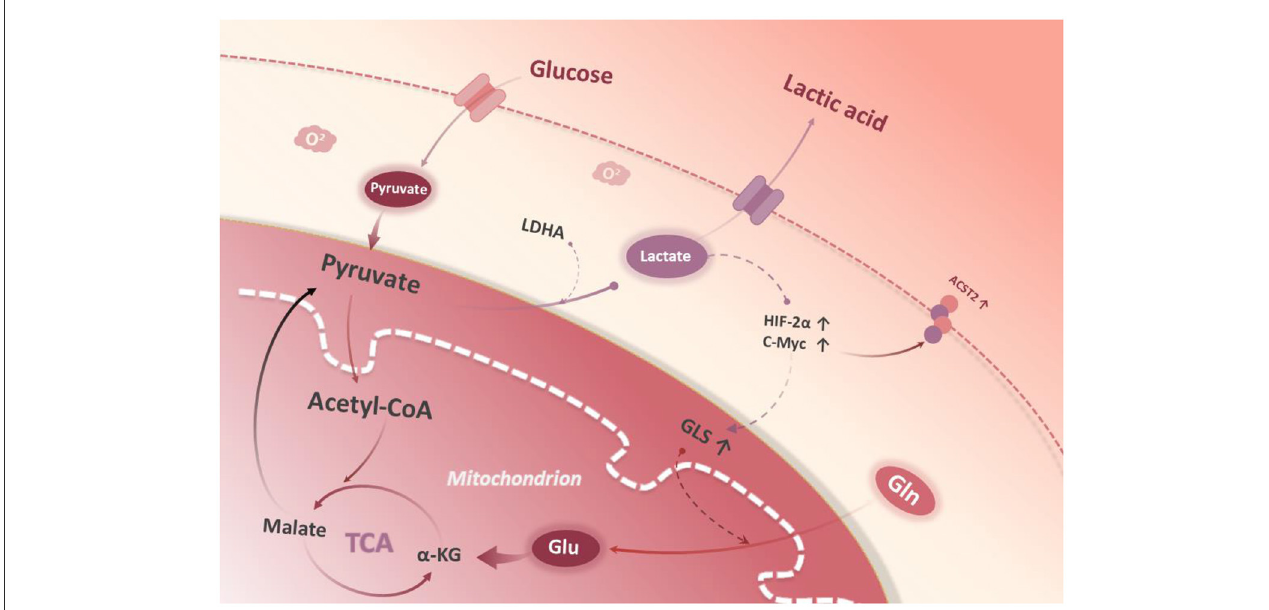
FIGURE1 Glycolysis and glutamine metabolism. Glucose is catabolized to pyruvate in the cytoplasm. Conversion of lactate from pyruvate stabilizes HIF-2a, which then stabilizes c-Myc protein expression in the nucleus. c-Myc promotes glutamine transporter protein 2 (ASCT2) expression. Glutaminase 1 (GLS1) catalyzes the breakdown of glutamine to glutamate in the mitochondria. In the mitochondrial matrix, glutamate is converted to a-KG and enters the tricarboxylic acid cycle.